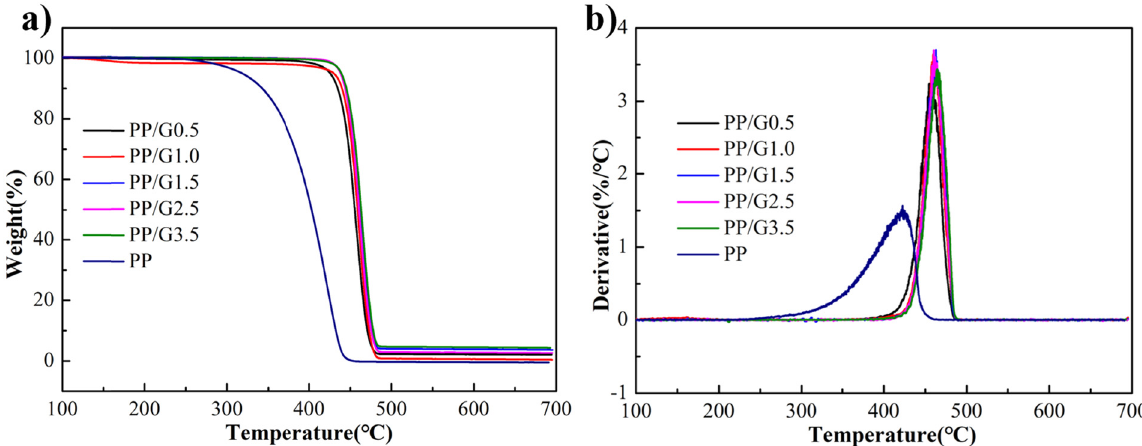
Figure 7: TGA ( a ) and DTG ( b ) curves of neat PP and PP/GNP nanocomposites under N